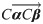
Comparison of the angle between the CαCβ→ directions in original Anton data and reconstructed data using the present CαO based Statistical Method and the Frenet frames based method of [22].a) for the villin data and b) for the ww-domain data.